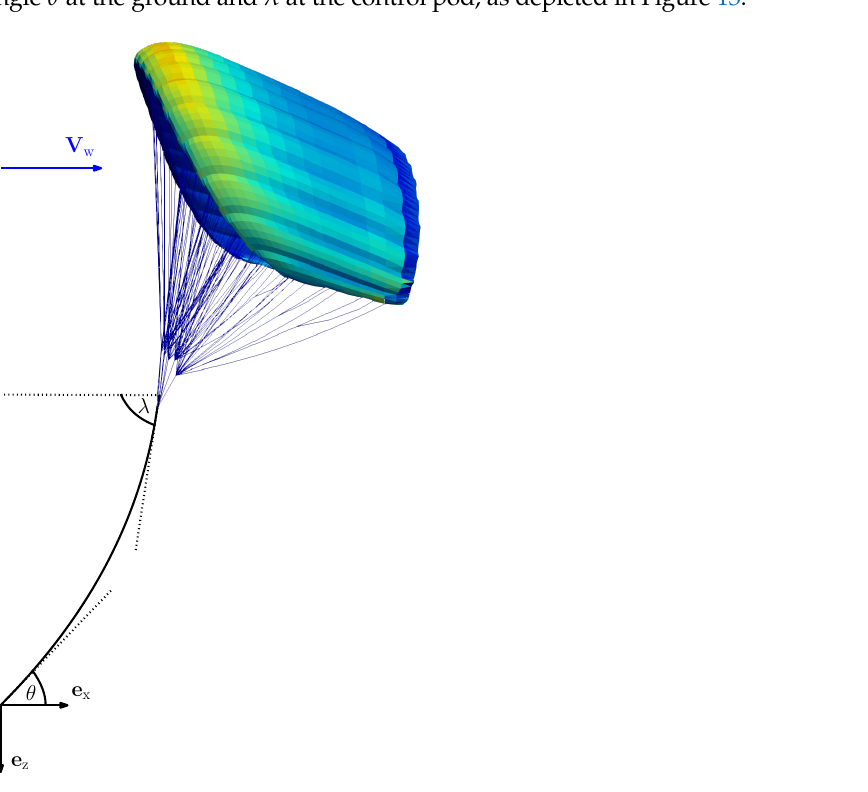
Figure 13. Schematic of the sagging tether during neutral flight, with elevation angle θ measured at the ground and the elevation angle λ measured at the kite. The coloring of the wing surface indicates the distribution of the computed aerodynamic surface pressure